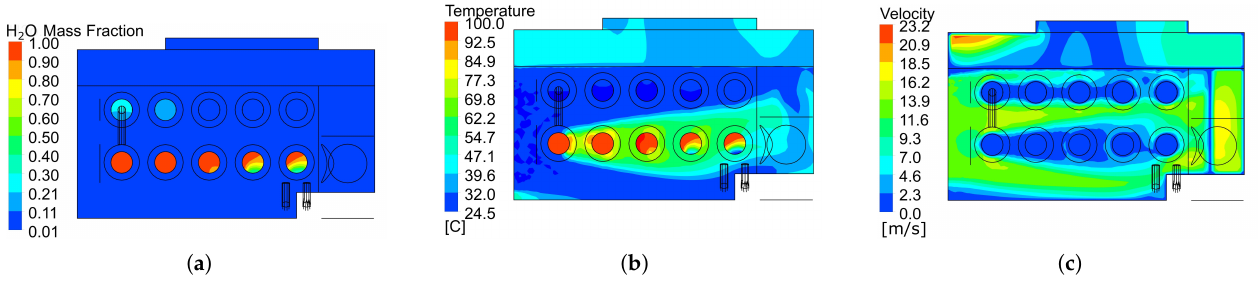
Figure 9. V1 cross-section: ( a ) H 2 O mass fraction; ( b ) temperature distribution; ( c ) velocity magnitude.